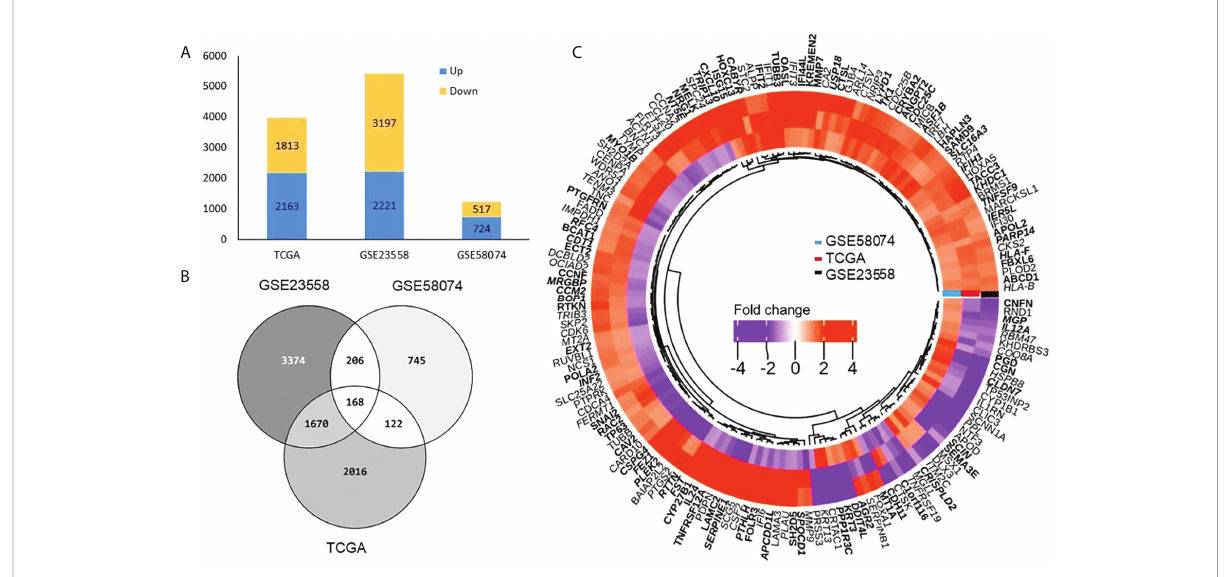
FIGURE 2 Differentially expressed genes (A) Bar graph representing total DEGs both up (blue) and down (yellow) in three datasets. (B) Venn diagram showing number of DEGs (common and unique) among TCGA, GSE23558 and GSE58074. A total of 168 common DEGs were obtained. (C) Heatmap shows DEGs related to doxorubicin response (GSE58074) and non-treated samples in OSCC from TCGA and GSE23558. Three types of distinct expression pattern are discernible (1) 52 genes overexpressed (orange) in all the three data sets, (2) 76 genes underexpressed in GSE58074 (purple) while overexpressed in TCGA (orange) and GSE23558 (orange), and (3) 26 genes underexpressed in TCGA (purple) and GSE23558 (purple) while overexpressed in GSE58074